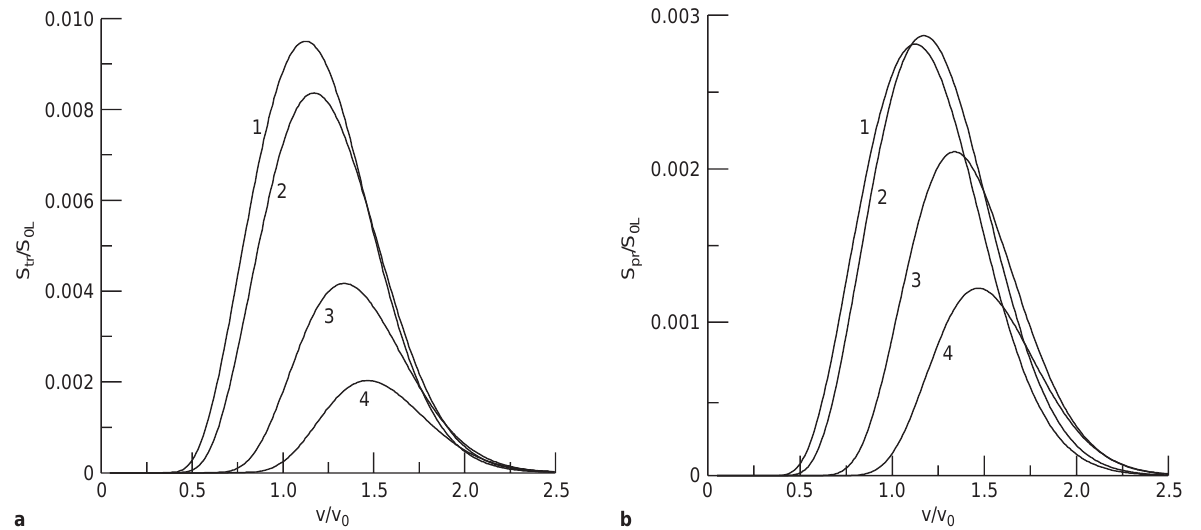
Fig. 6a, b. Energetic spectrum of a trapped and b precipitating energetic electron flux at low altitude for weak di(cid:128)usion for di(cid:128)erent u values. D v = v 0 (cid:136) 0 : 6 ; u (cid:25) 7 : 8 (cid:14) ; u (cid:25) 8 : 9 (cid:14) ; u (cid:25) 14 : 5 (cid:14) ; u (cid:25) 20 : 5 (cid:14) ; other parameters are as in Fig. 2 1 2 3 4